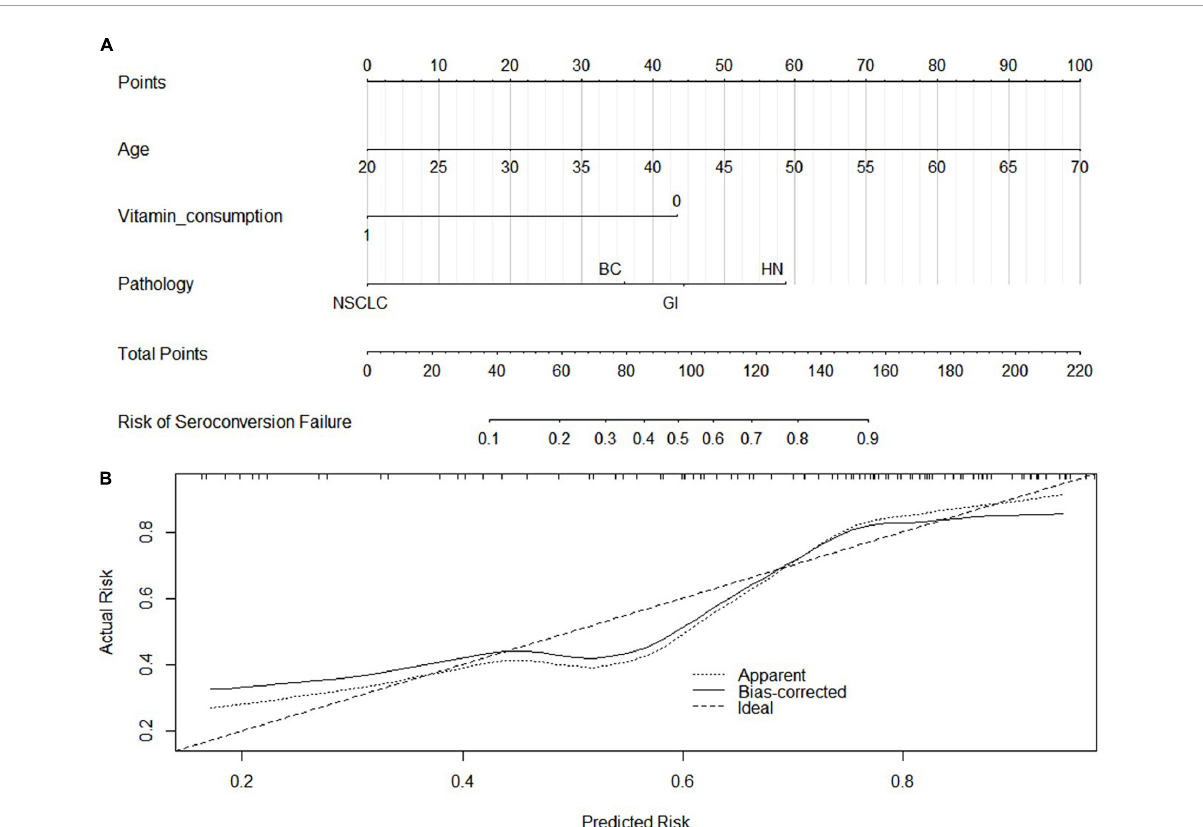
FIGURE2 Nomogram Development (A) by using the significant variables in the regression analysis and calibration curve (B) . NSCLC, Non-small cell lung cancer; GI, gastrointestinal cancers; HN, head and neck cancers; BC, Breast Cancers. The C-index and calibration curve was derived based on the regression analysis. The C-index was 0.8 and the internal calibration curve was shown.